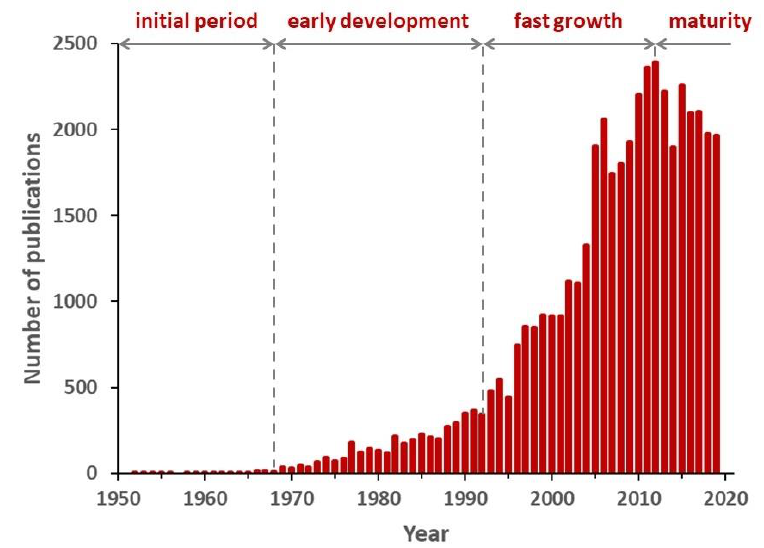
Figure 1. Number of publications between 1950 and 2019.